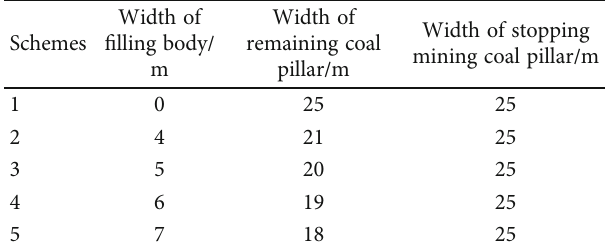
Figure 8: Balance state of coal wall. Table 4: The scheme of replacing partial stopping mining coal pillar with concrete fi lling